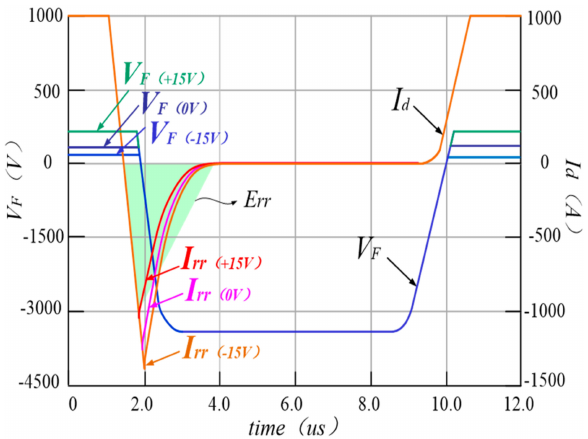
Figure 3. Waveforms of the RC-IGBT internal diode switching